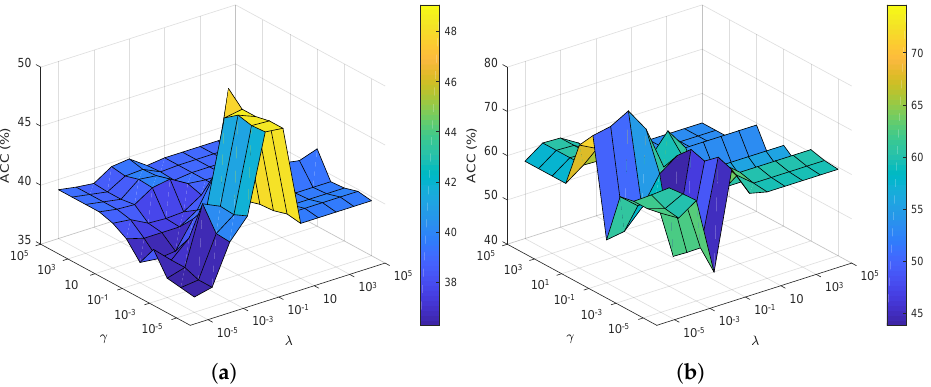
Figure 3. ACC (%) versus parameters λ and γ of the proposed method on the ( a ) BBCSport dataset with 10% observed paired samples; ( b ) MSRC-v1 dataset with 50% missing instances of each